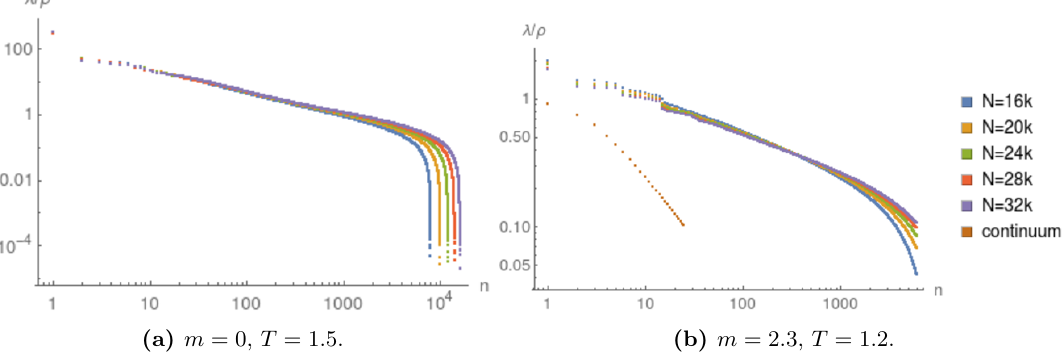
Figure 19. Log-log plot of the positive eigenvalues of i (cid:1), in 4d de Sitter. In the massive case on the right we plot the largest 6000 positive eigenvalues and the corresponding continuum eigenvalues from the (cid:12)nite T mode comparison results of